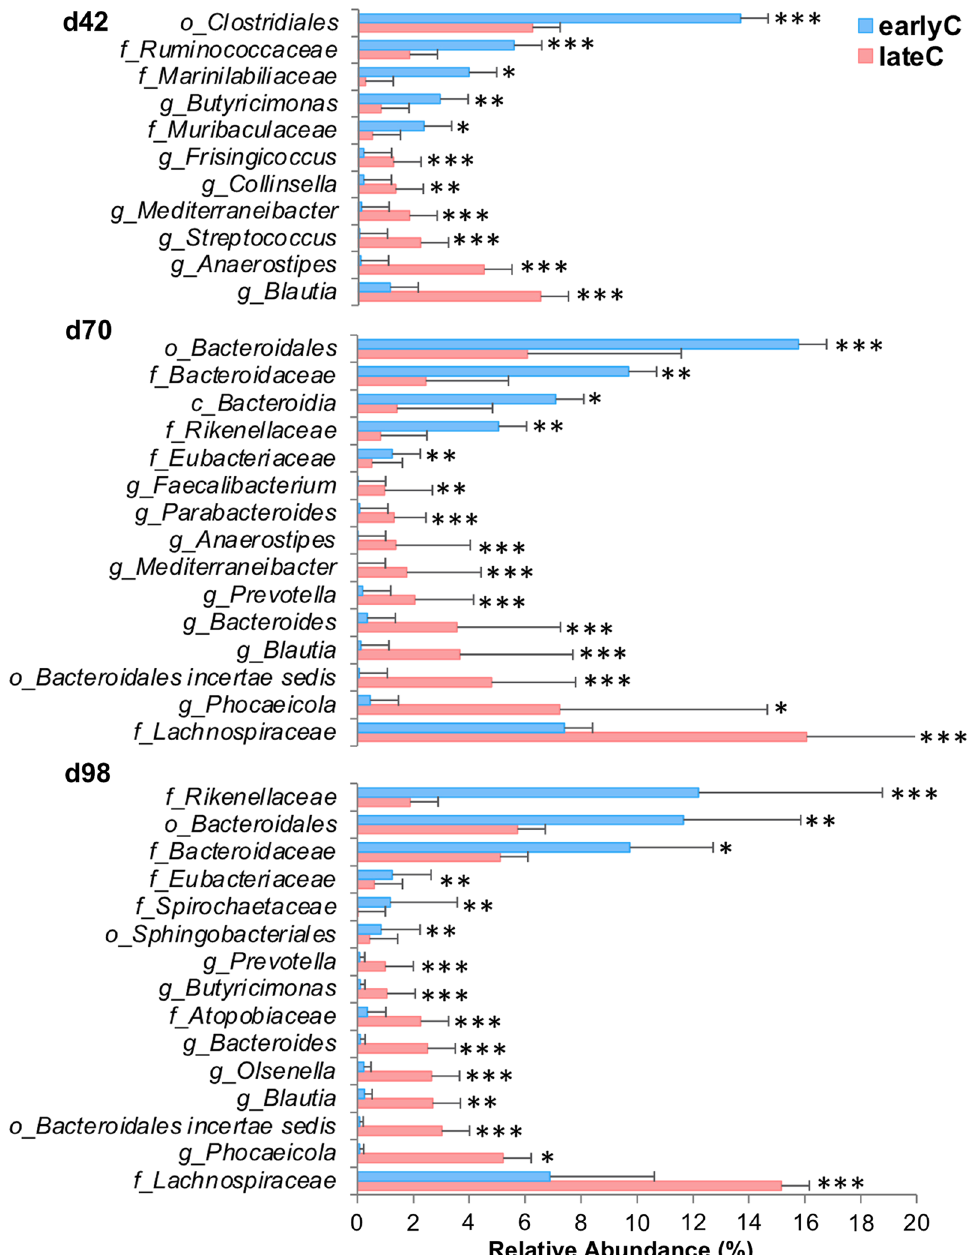
Fig. 3 Changes in faecal bacterial communities of calves due to weaning event. Significantly different bacterial genera with relative abundance ( 1%) and p 0.05 (Kruskal–Wallis test) among same‑age old weaning groups are shown. Each bar represents an average value for animals: d42 ≥ ≤ (25 & 23), d70 (26 & 21), d98 (27 & 22) animals for earlyC and lateC groups,